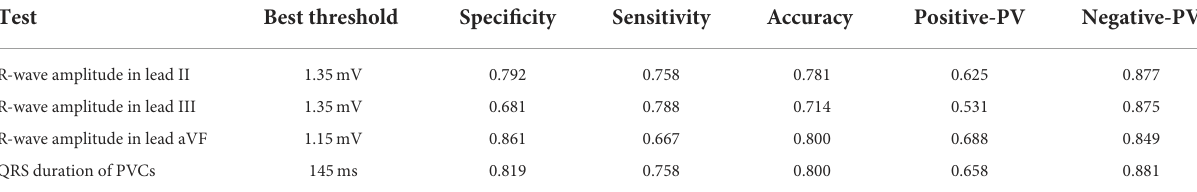
TABLE 3 Best threshold analysis.